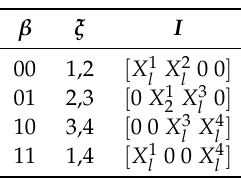
Table 2. Look-up table for ( s = 4, v = 2 )